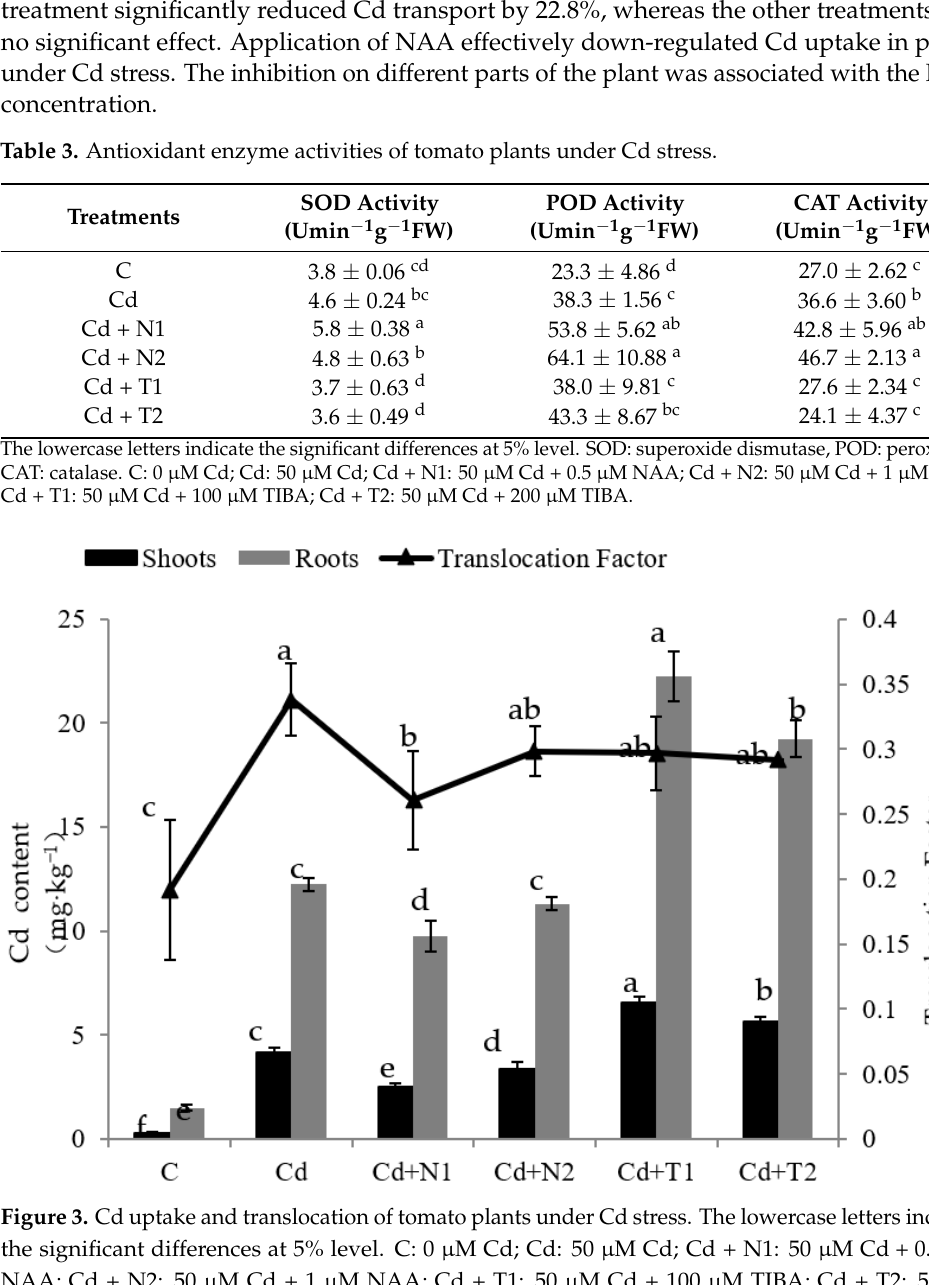
POD Activity (Umin − 1 g − 1 FW)